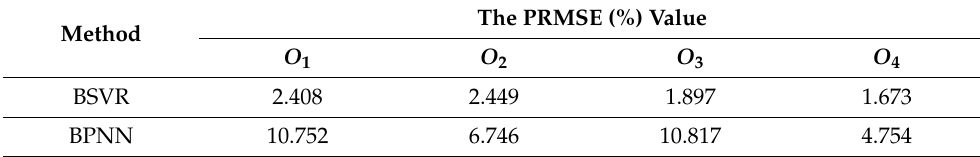
Table 6. The PRMSE of Each Output Node.